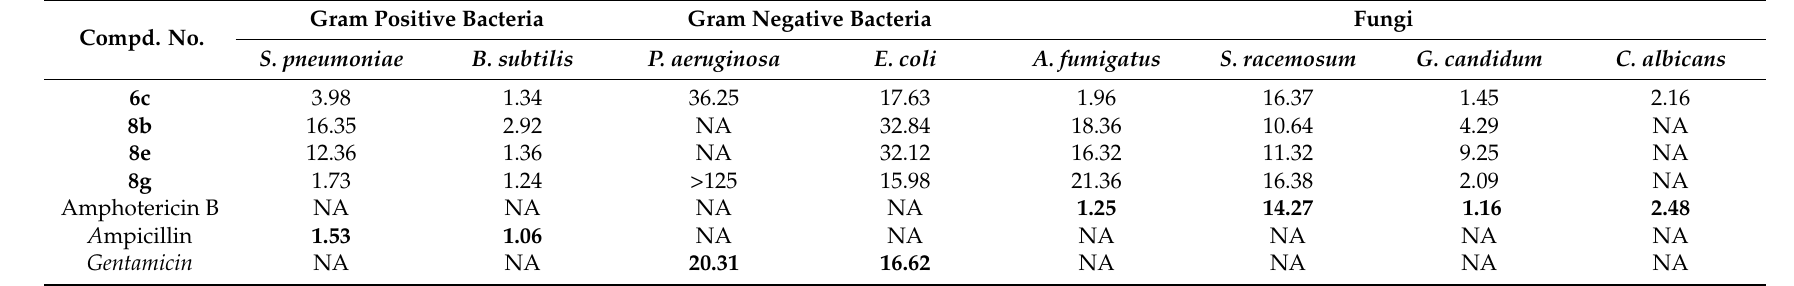
Table 5. Antimicrobial Activity as IC 50 ( µ g/mL) of tested samples against tested microorganisms.